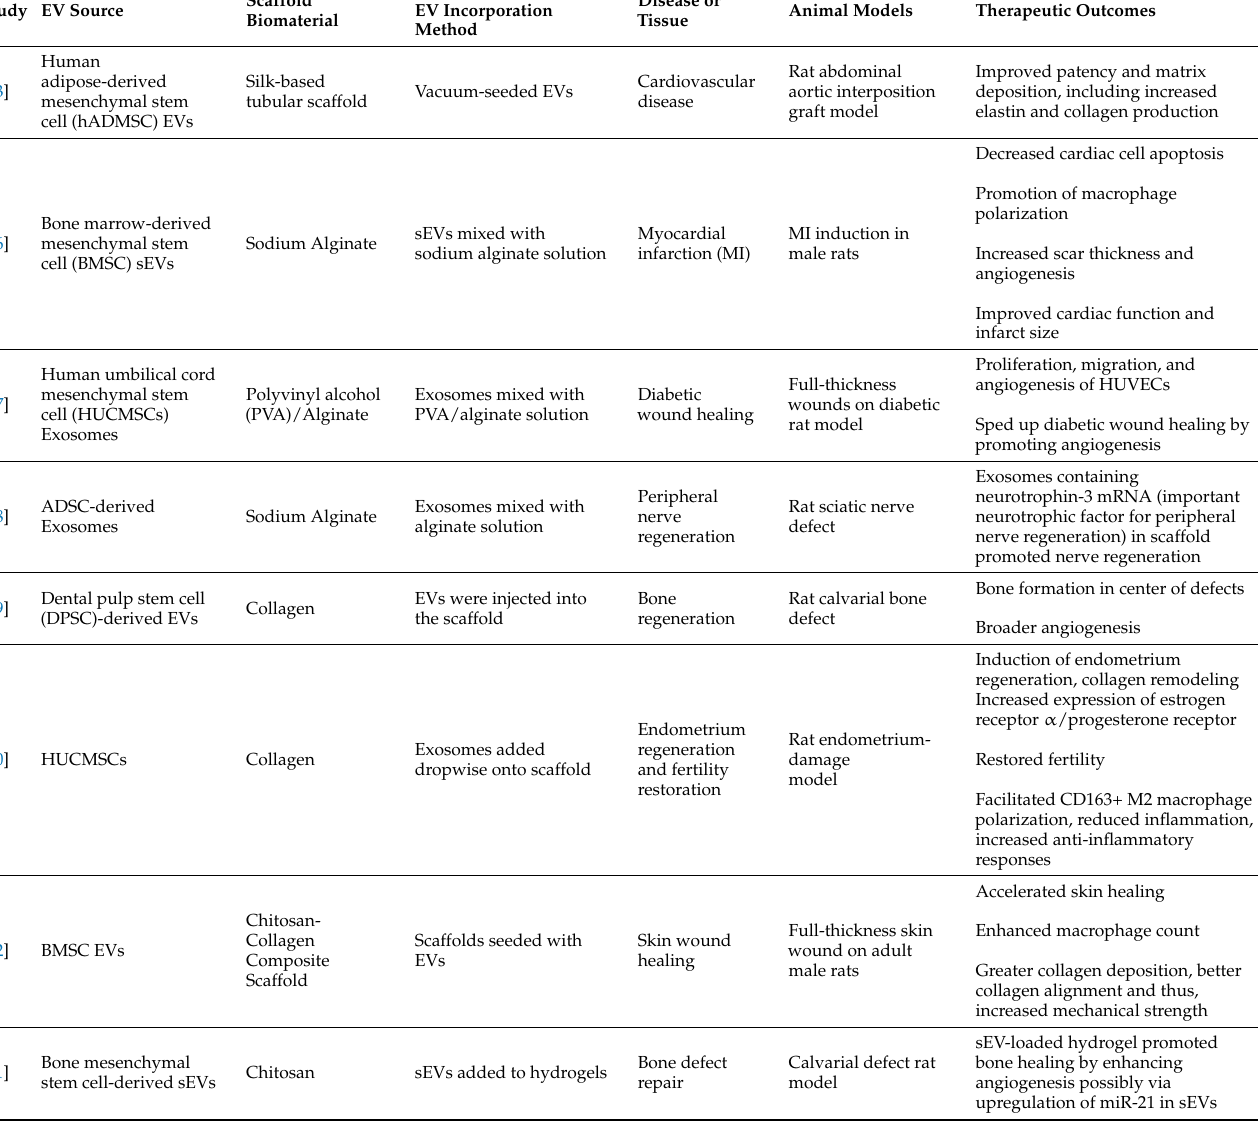
Table 1. The therapeutic applications of natural and synthetic biopolymer-based scaffolds that utilize extracellular vesicles. The type of EV and biopolymer used in each study are indicated as well as the EV incorporation method into the